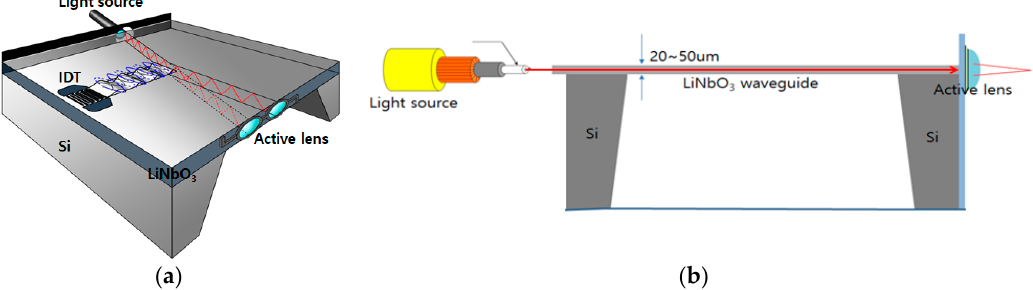
Figure 1. Overall schematic view of the developed AO system. ( a ) 3D view and ( b ) cross-sectional (artificial) view.